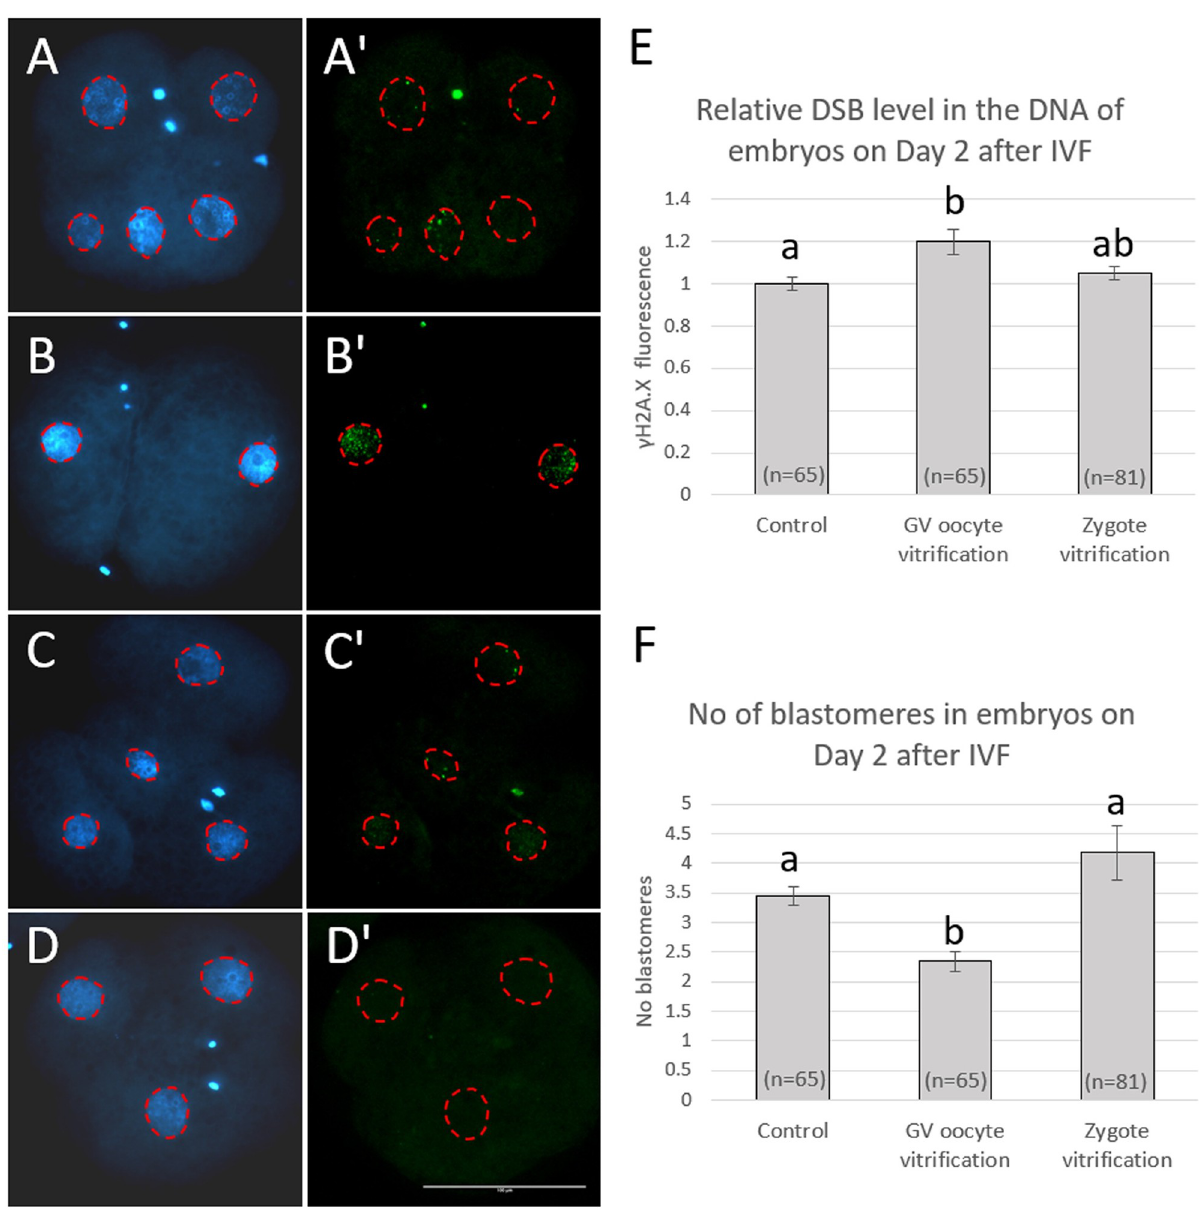
Fig 3. Fluorescent images of DNA (blue, A-D) and the DSB marker γ H2AX (green A’-D’) in cleavage-stage embryos 48 h after IVF, relative DSB levels (E) in embryos obtained from oocytes without vitrification (Control), oocytes vitrified/warmed at the GV-stage and pronuclear zygotes vitrified 8 h after IVF, and (F) numbers of blastomeres in respective embryos. A-A’: a representative embryo obtained without vitrification; B-B’: a representative embryo obtained from a vitrified GV-stage oocyte; C-C’: a representative embryo obtained from a vitrified zygote; D-D’: a representative embryo processed without anti- γ H2AX (negative control). γ H2AX measurement area is highlighted with red dashed line. The scale bare represents 100 μ m. Data are shown as mean ± SEM. Values with different superscripts (a and b) differ significantly (P < 0.05). The experiment was replicated five times. Total number of oocytes/embryos in each group are given in